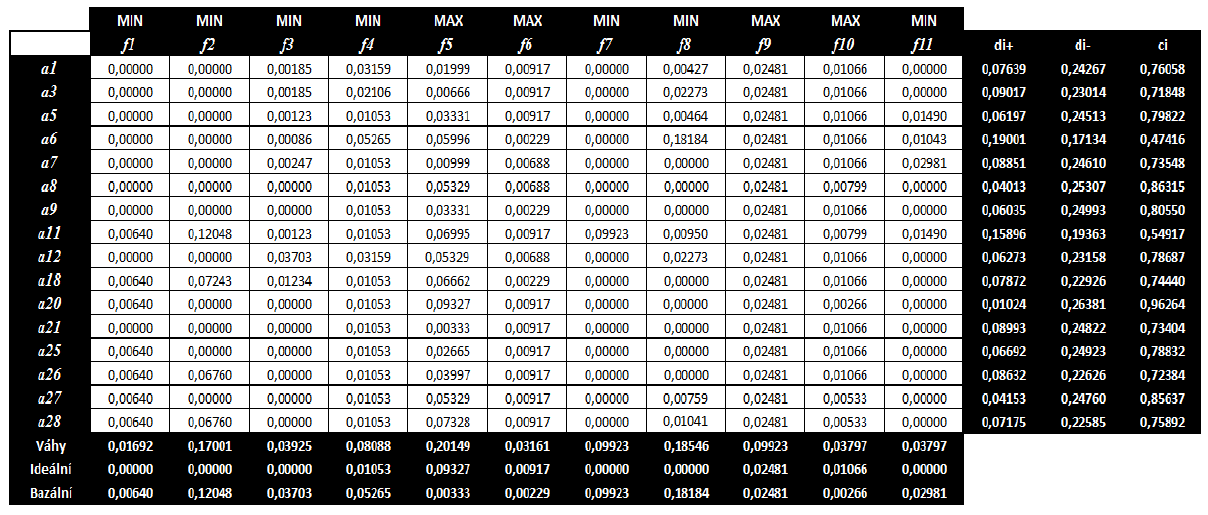
Table 7. Weighted criterial matrix for savings accounts